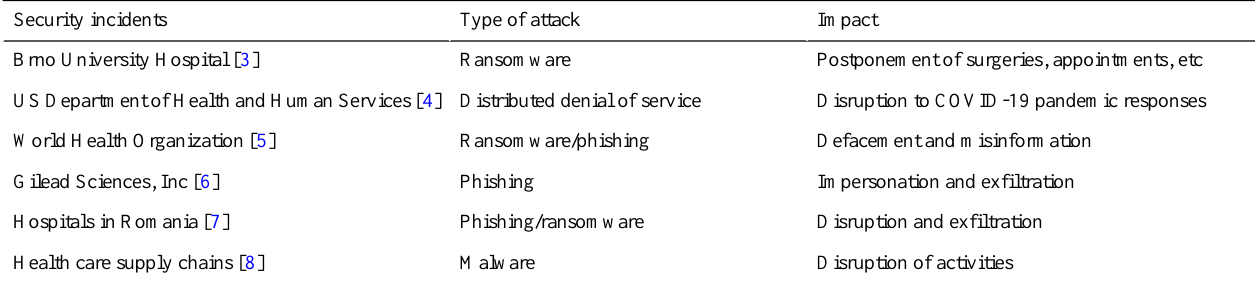
Table 2. Security incidents during the COVID-19